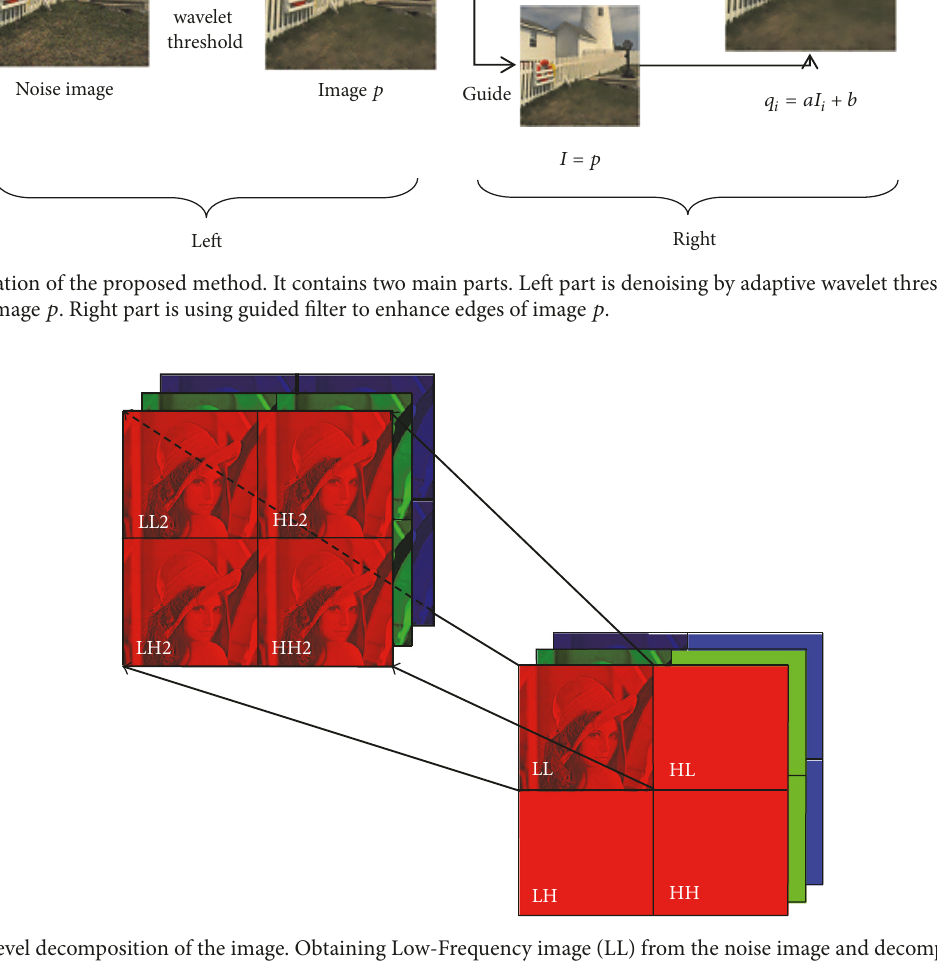
Figure 2: Two-level decomposition of the image. Obtaining Low-Frequency image (LL) from the noise image and decomposing it resulting in subbands LL2, HL2, LH2, and HH2. The adaptive wavelet shrink algorithm is applied to each subband to denoise the